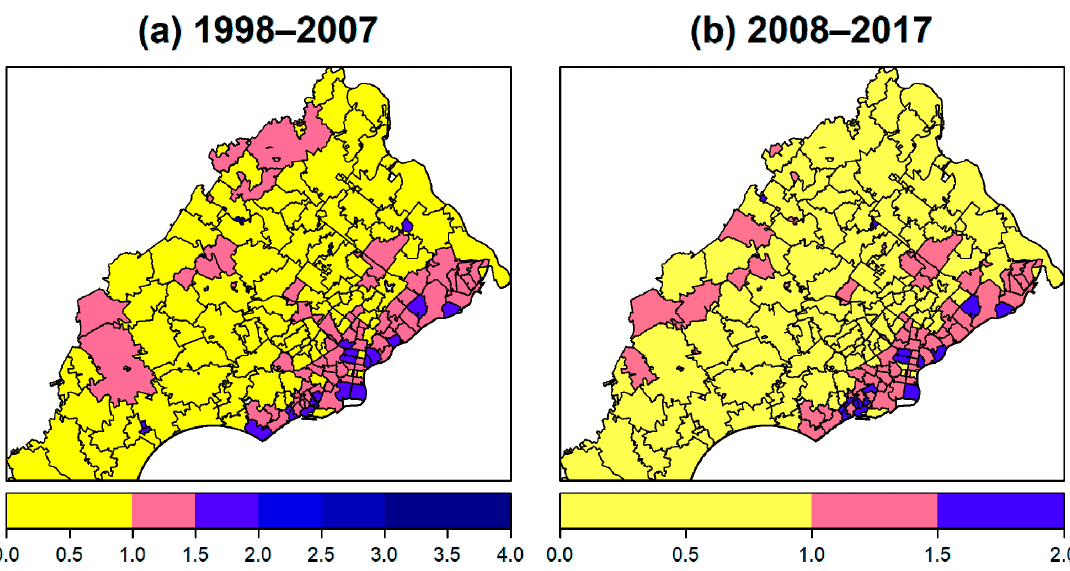
Figure 5. Maps of incidence rate ratio of each ZIP code’s rate to the PA state rate for ( a ) 1998 to 2007 period, and ( b ) 2008 to 2017 period.